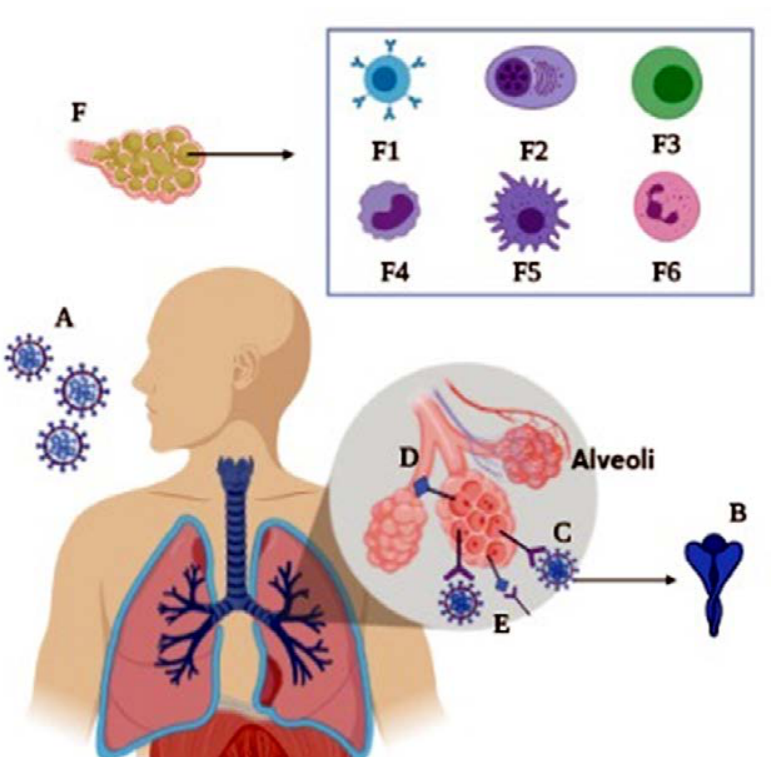
Fig. 1. Immune response causing pneumonia in alveoli is shown. A: SARS CoV-2 aerosol taken, B: Coronavirus spike protein, C: binding to ace 2 receptor with coronavirus spike protein, D: ADAM 17 receptors are activated, trying to reduce the number of ACE 2. B-lymphocytes (F1), plasma cells (F2), T cells (F3), monocytes (F4), macrophage (F5), neutrophil (F6) provides “cytokine storm”. F: The development of pneumonia following the cellular defense